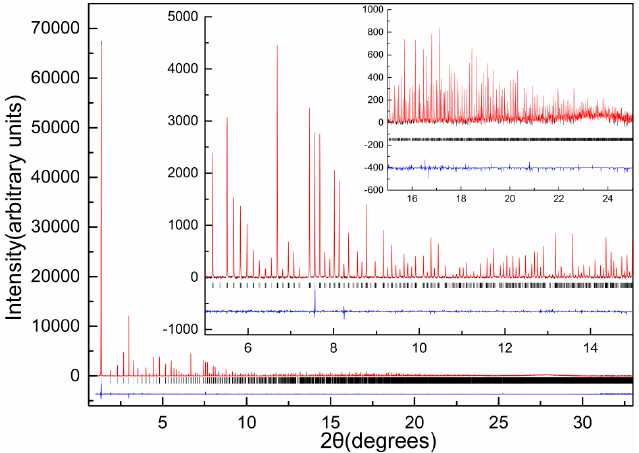
Figure 14. Pawley fit of diffraction pattern of HI crystallized at pH 8.56 (space group I 2 1 3), collected on ID22 at ESRF ( λ = 1.29974(6) Å, 280 K). The black, red and blue lines represent the experimental data, the calculated pattern and the difference between the experimental and calculated profiles, respectively. The vertical bars correspond to Bragg reflections compatible with space group I 2 1 3. Insets correspond to magnifications of the fit in selected 2 θ ranges